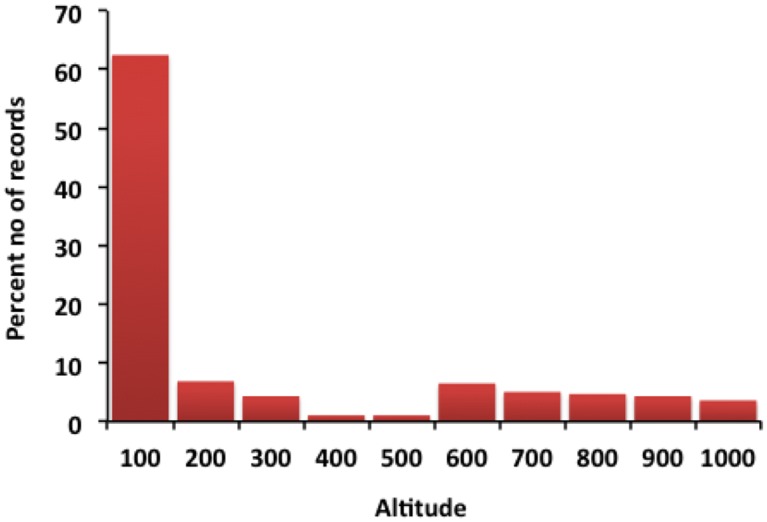
Percent number of records of A.fulica invasion along the altitudinal gradient.